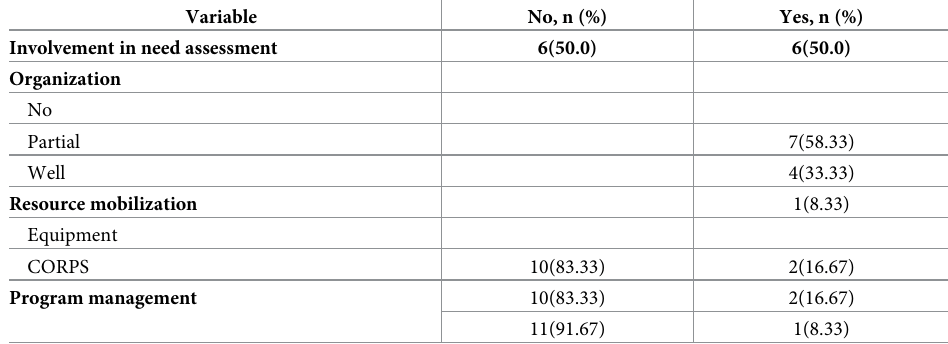
Table 5. Vector Control Coordinators’ perception on the level of community participation in the implementation of biolarviciding.